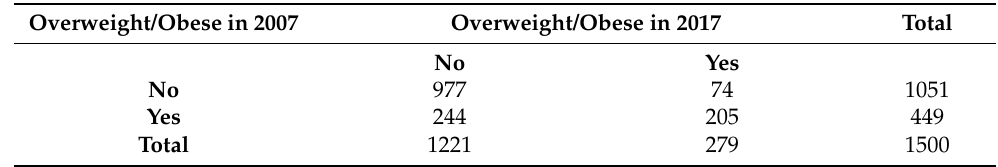
Table 3. McNemar’s test assessing change in proportion of overweight/obese status in the study sample from 2007 to 2017.